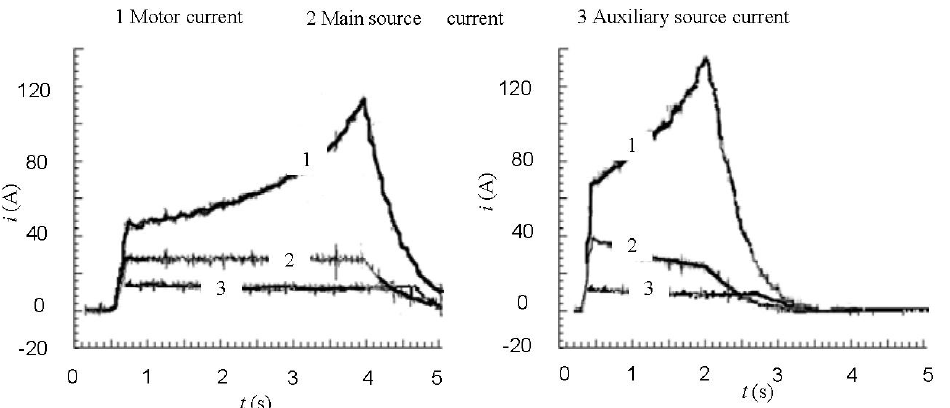
Figure 14. (a) the RMS currents at a soft brake mode; (b) the RMS currents at an emergent brake